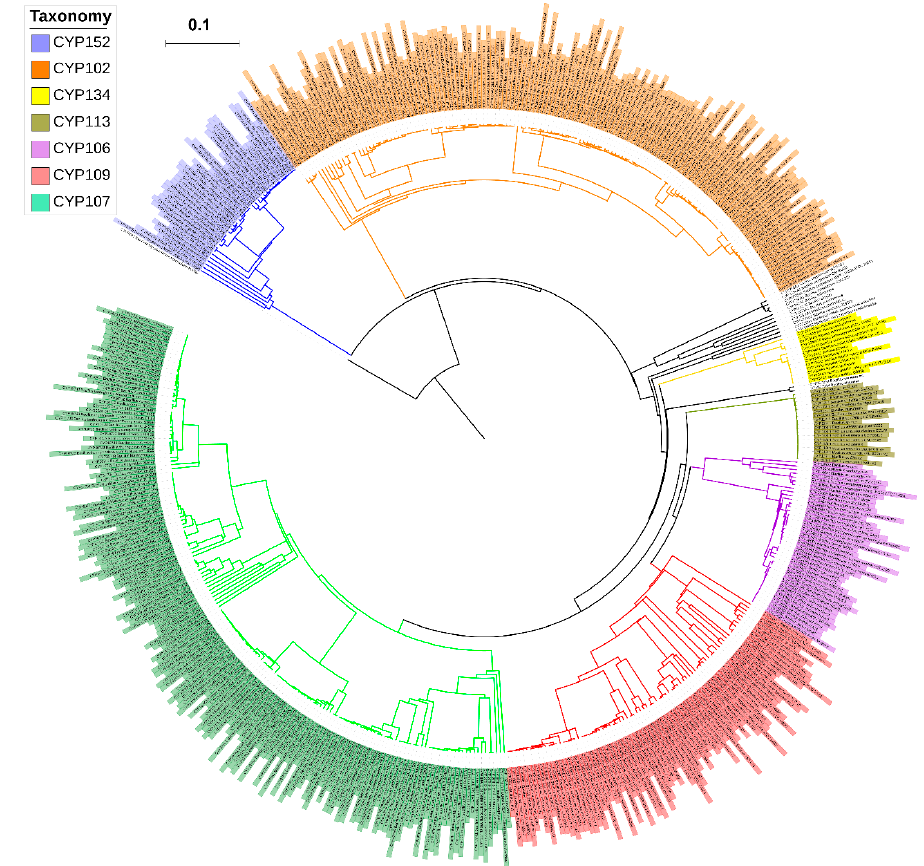
Figure 1. Phylogenetic analysis of Bacillus species P450s. Dominant P450 families were indicated in different colors. CYP51B1 from Mycobacterium tuberculosis H37Rv is used as an outgroup. A high-resolution phylogenetic tree is provided in the supplementary Figure S1.